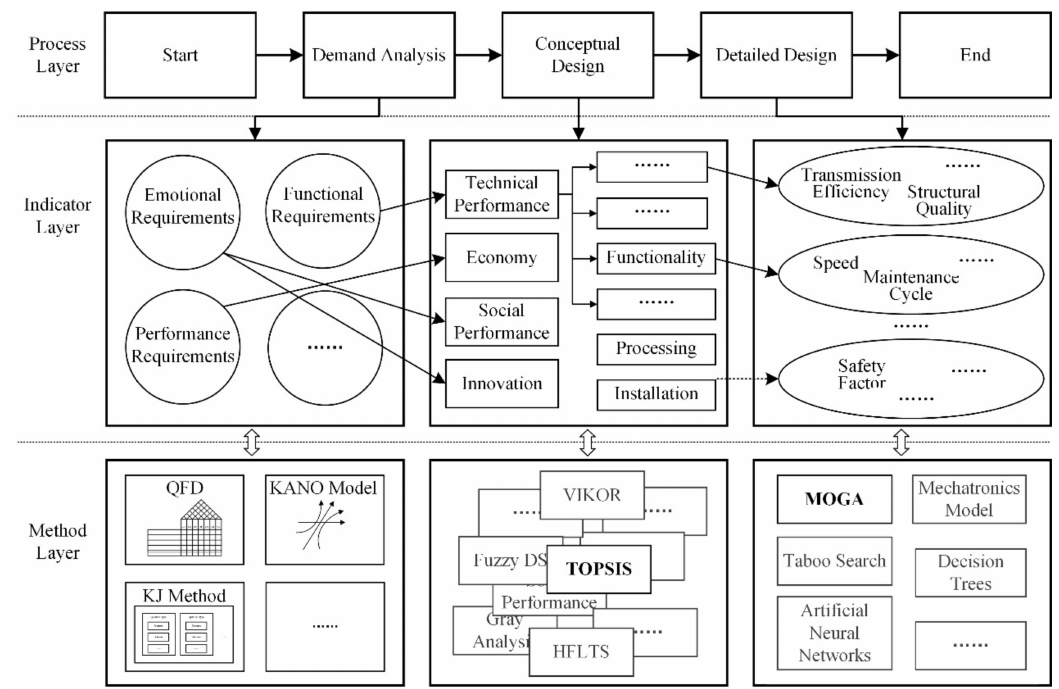
Figure 1. The framework of the multi-indicators decision